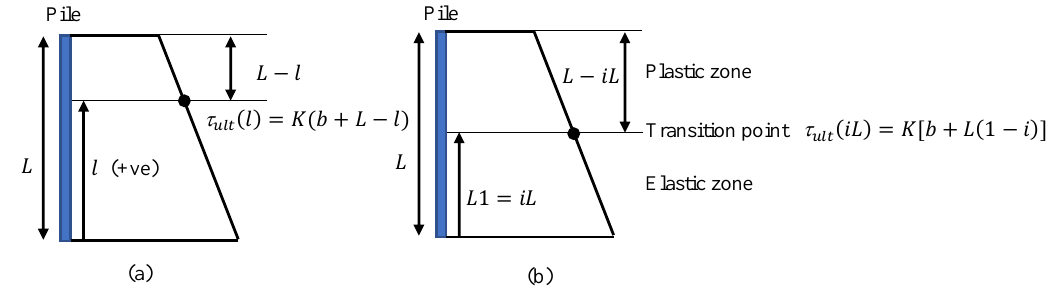
Figure 13. ( a ) Shaft strength profile, ( b ) transition between elastic and plastic portions.